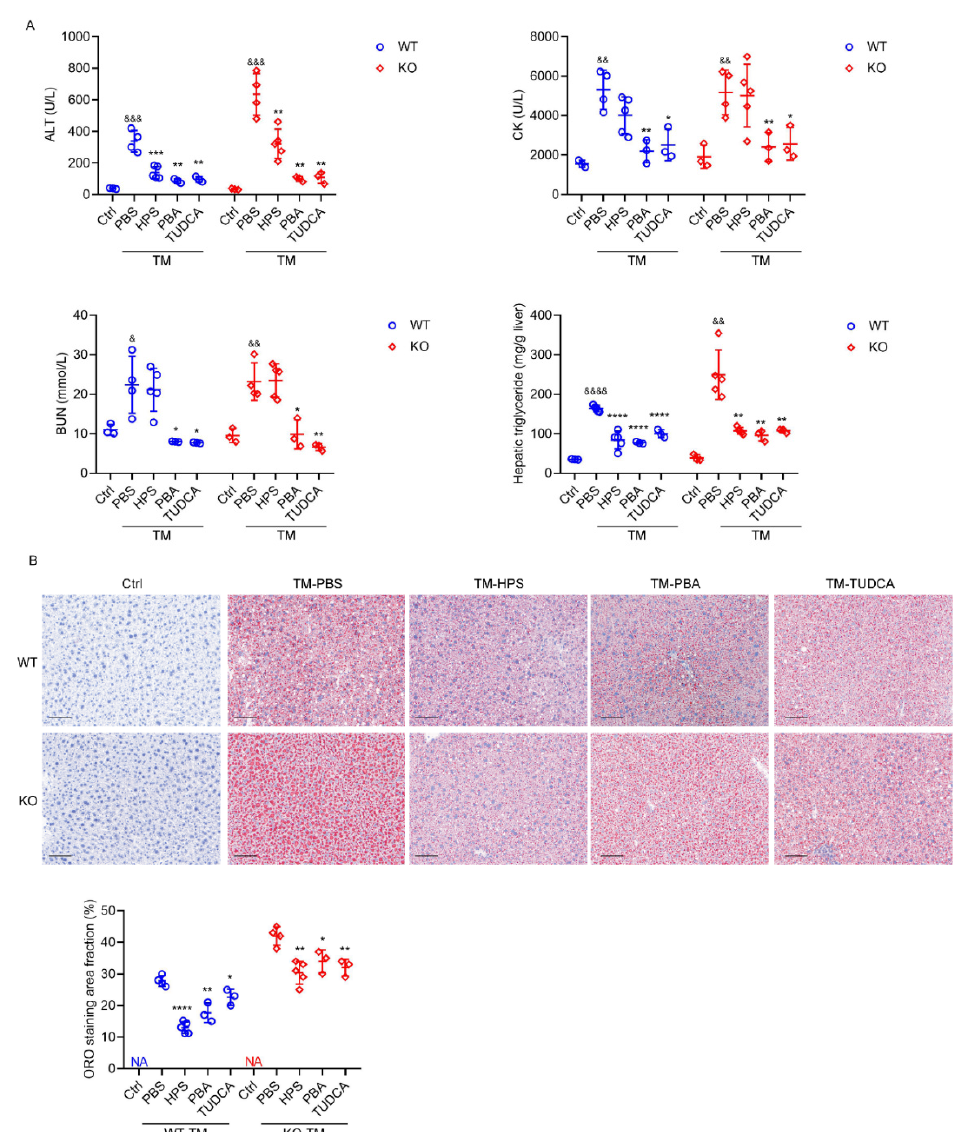
Figure 8. HPS ameliorate TM-induced hepatic steatosis. Eight-week-old WT and HPS-KO mice were injected intraperitoneally with TM (1 mg/kg body weight) for 24 h. Six hours after injection of TM, WT or HPS-KO male mice were injected intraperitoneally with rhHPS (1 mg/kg) or PBA (100 mg/kg) or TUDCA (250 mg/kg). ( A ) Serum ALT, BUN and CK levels and hepatic triglyceride levels of the mice ( n = 3–5). ( B ) Representative images of ORO-stained liver sections of the mice as indicated. Scale bar = 100 μ m. The ORO staining area fraction was quantitated using ImageJ software and values are the mean ± SD of 3–5 liver sections of measurements. Data are expressed as mean ± SD of all samples for each group. The significant difference between the mean relative values of two groups was analyzed by Student t test (* p < 0.05, ** p < 0.01, *** p < 0.001, **** p < 0.0001 versus corresponding TM-PBS; & p < 0.05, && p < 0.01, &&& p < 0.001, &&&& p < 0.0001 versus corresponding ctrl).